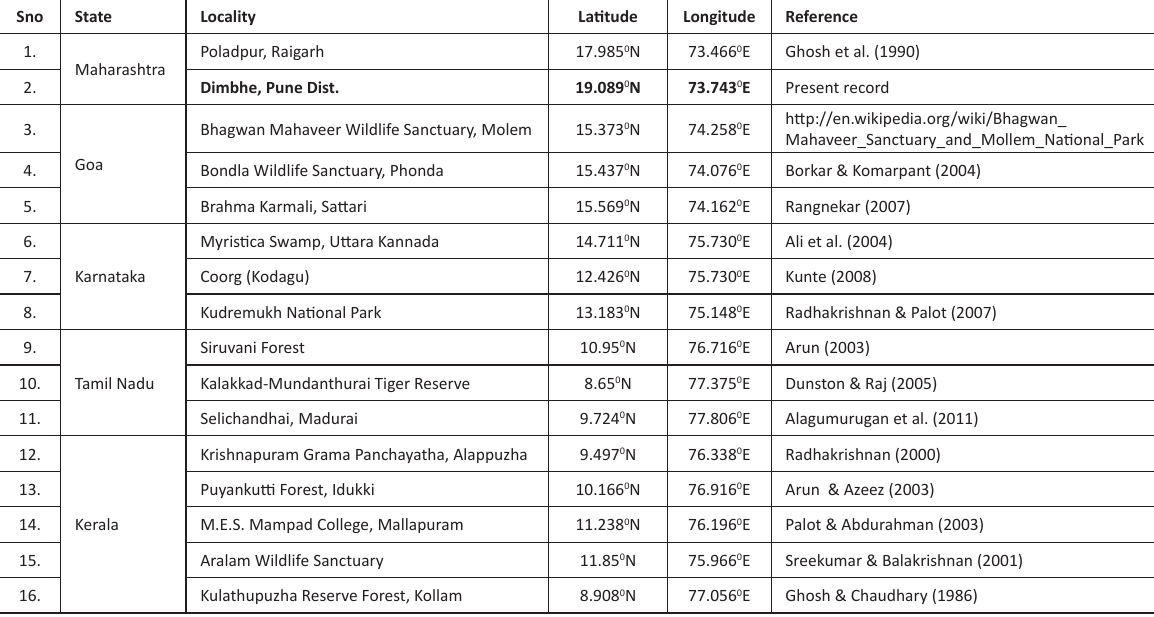
Table-1. Indicating state wise distributional records of Idea malabarica Moore